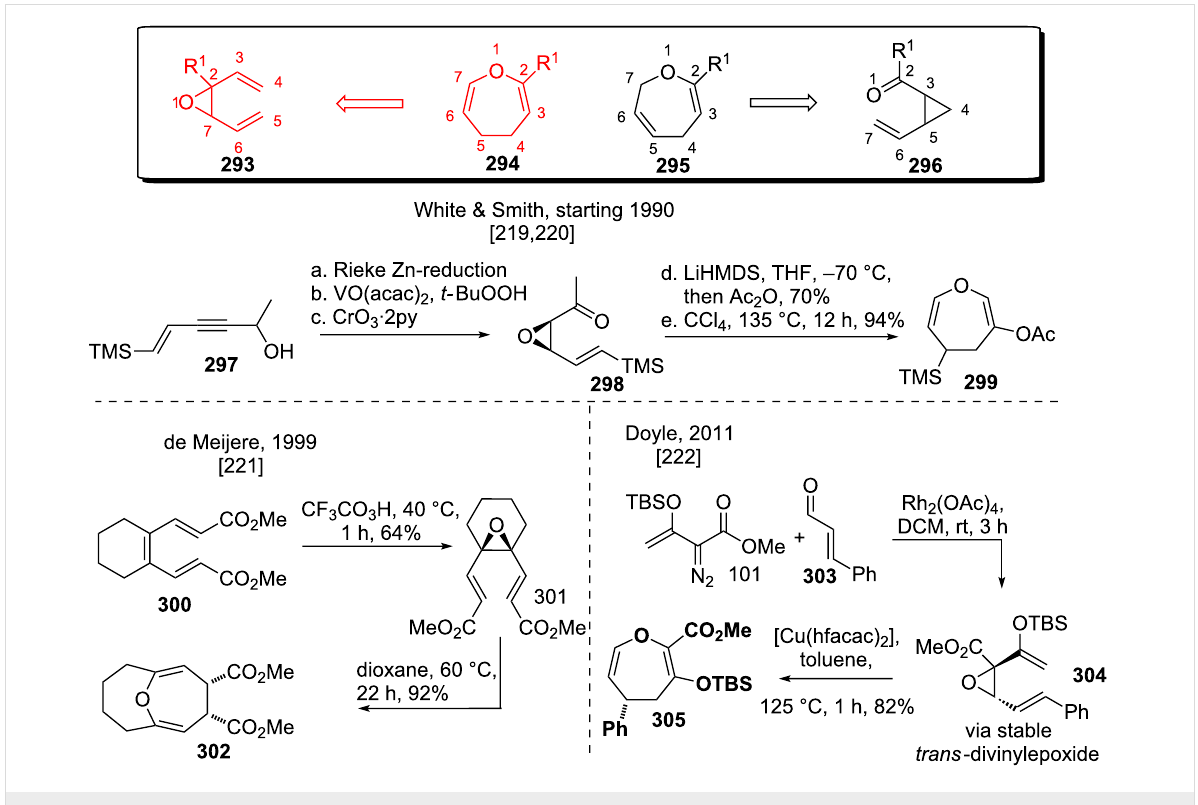
Scheme 36: Studies on the divinylepoxide rearrangement.